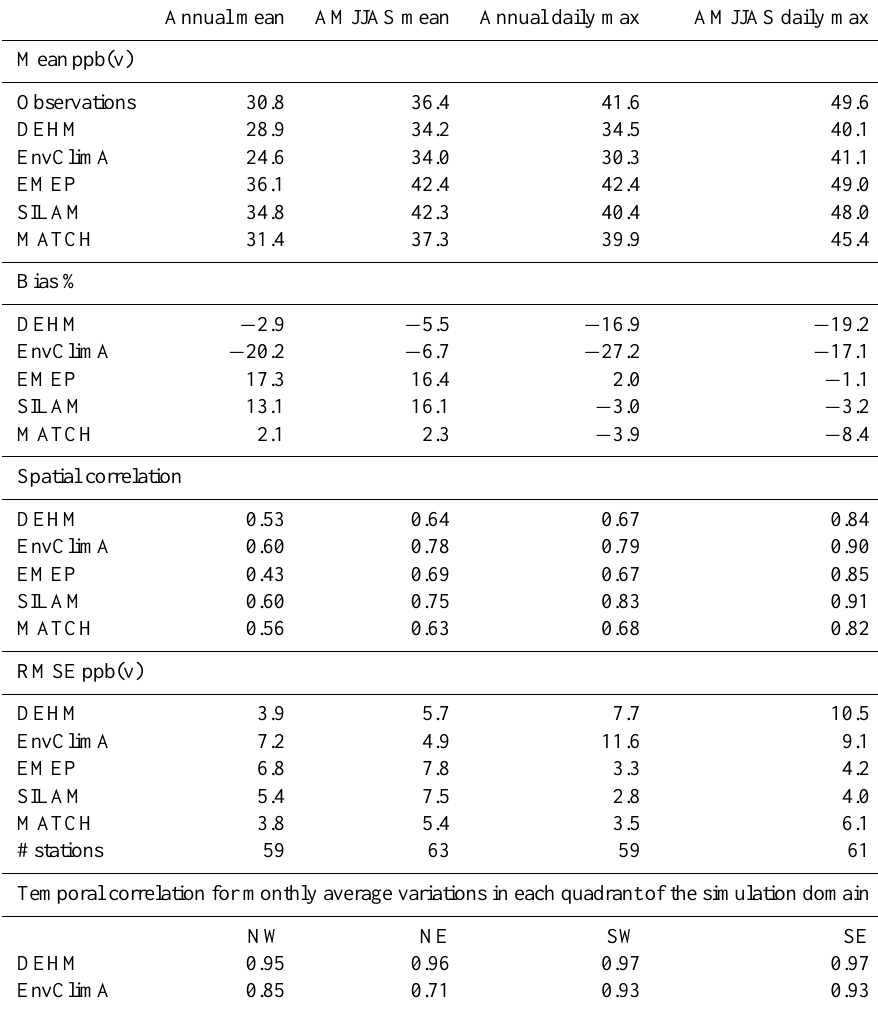
Table 3. Statistical evaluation of model results for surface O 3 ∗